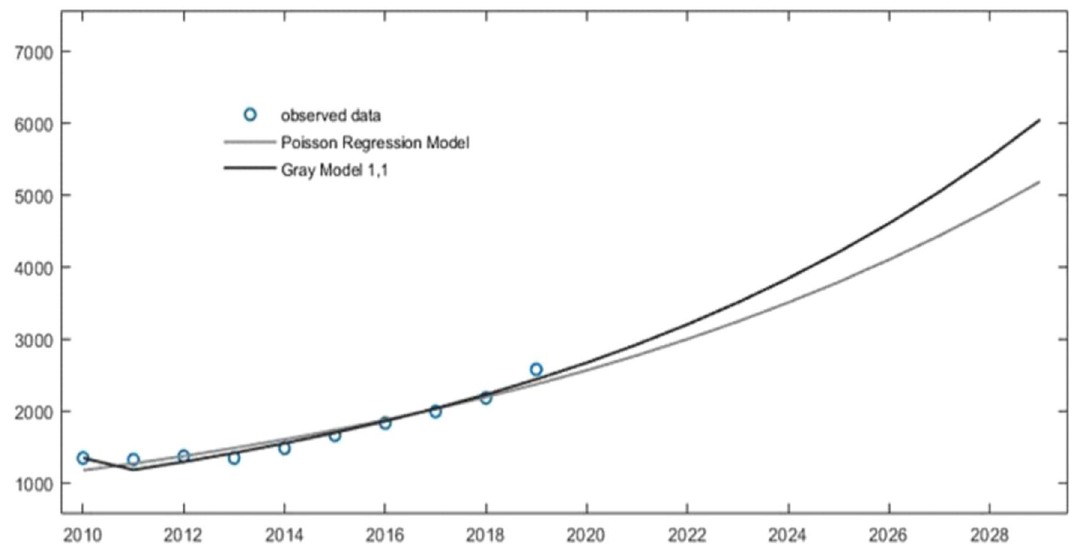
Figure 3. Projected modelling of hypertrophic cardiomyopathy to the next decades. HCM hypertrophic myocardiopathy. Last